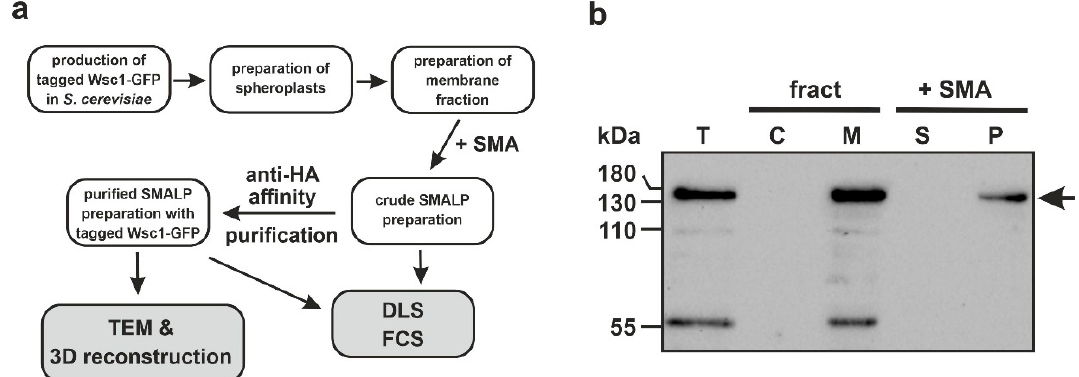
Figure 2. Purification and examination of styrene maleic acid lipoproteins (SMALPs) containing Wsc1-green fluorescent protein (GFP). ( a ) General scheme of the experimental strategy followed in this work. ( b ) Immunoblot analysis of cell fractionation and solubilization of the sensor fusion in the styrene maleic acid (SMA) polymer. T = total cell lysate; fract = cell fractionation with C = soluble cytosolic proteins, M = membrane-bound, pelleted fraction; +SMA = solubilization with SMA with S = supernatant (i.e., SMALPs), P = pellet with debris. The arrow indicates the signal of the presumably highly glycosylated sensor, according to [50].